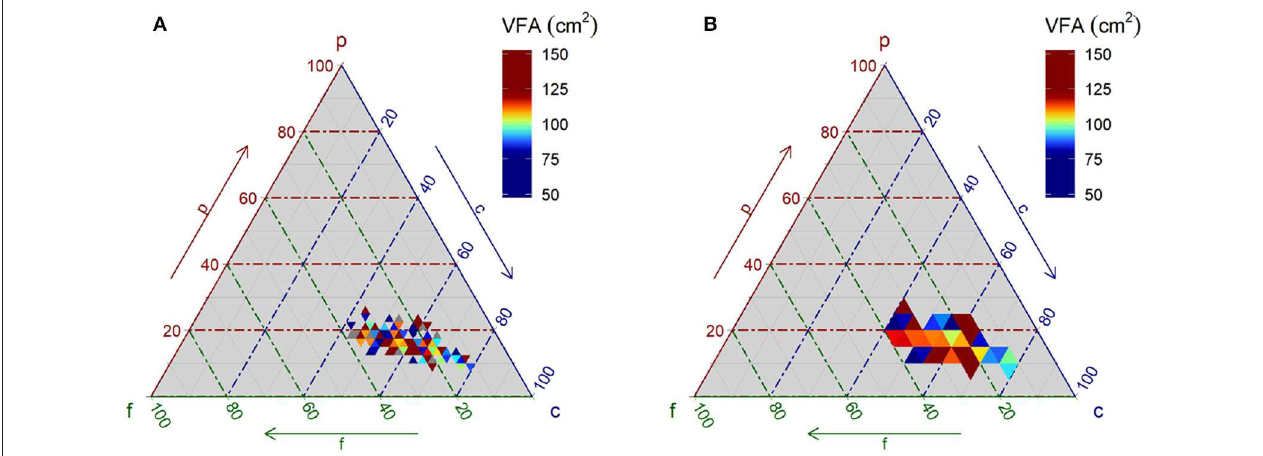
FIGURE 2 | Relationship between macronutrient energy ratio and visceral fat area. Data of senior male subjects obtained through a questionnaire at community health examinations is plotted. The visceral fat area in color is the mean of data within each small, triangular area. The composition is discretized by 2.5% in (A) and 5% in (B) .